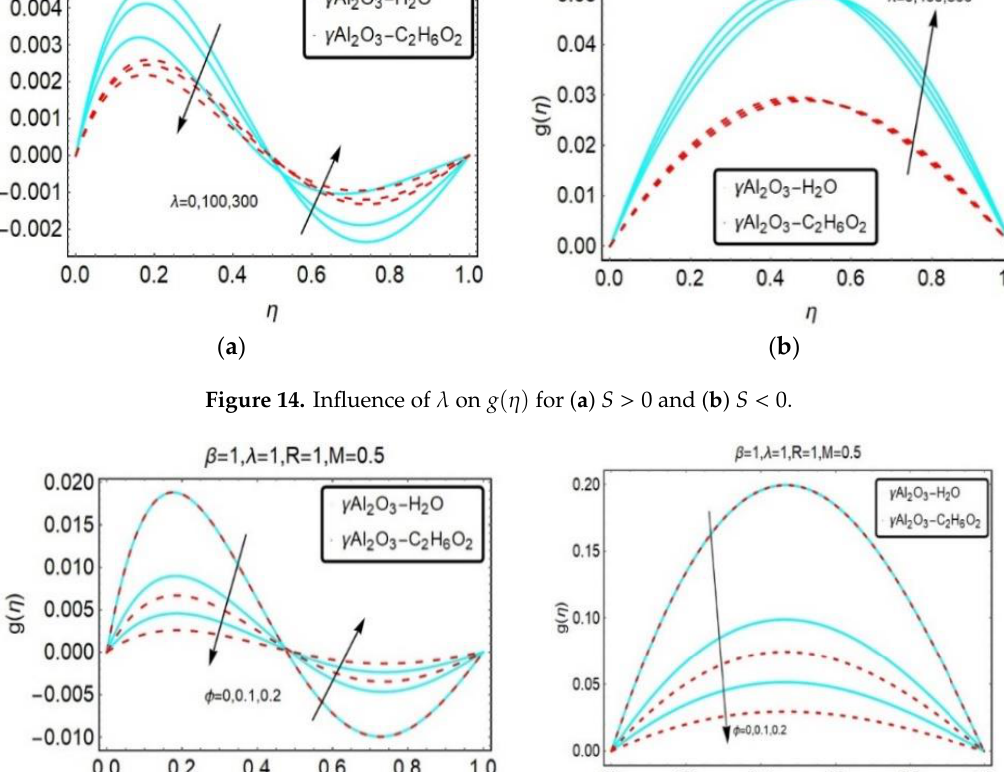
Figure 13. Influence of 𝑀 2 on 𝑔(𝜂) for ( a ) 𝑆 > 0 and ( b ) 𝑆 < 0.